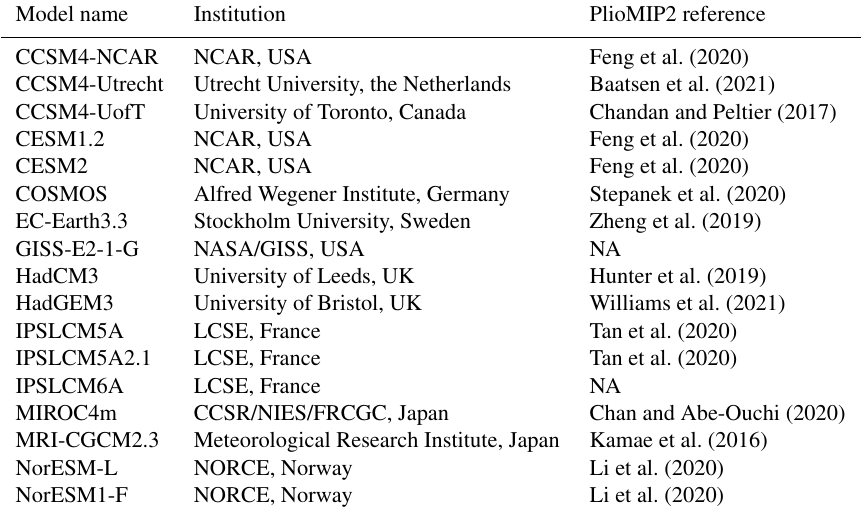
Table 1. Models participating in PlioMIP2 used in this study.